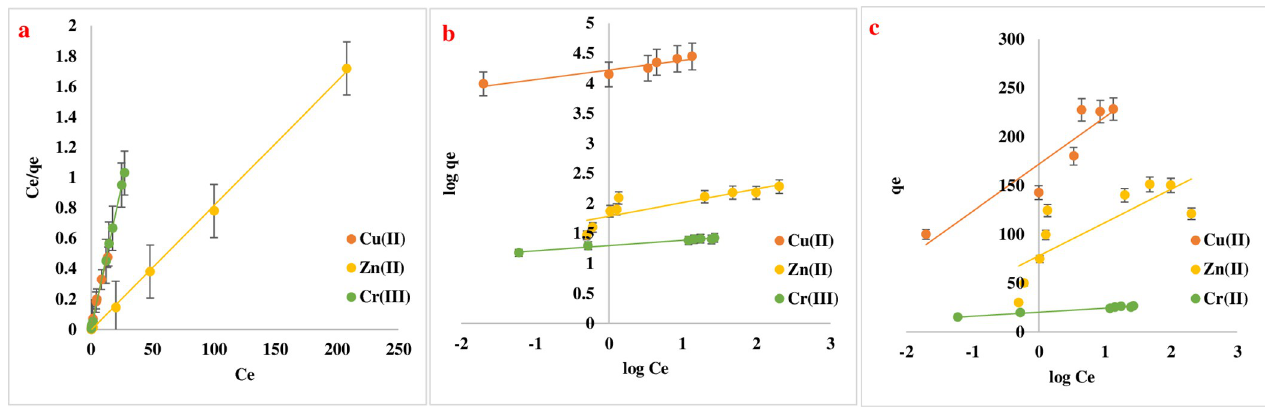
Fig 11. Adsorption isotherm of Cu(II), Zn(II) and Cr(III) onto Imine (a) linear plot of Langmuir model, (b) linear plot of Freundlich isotherm model, and (c) linear plot of Temkin Isotherm model.